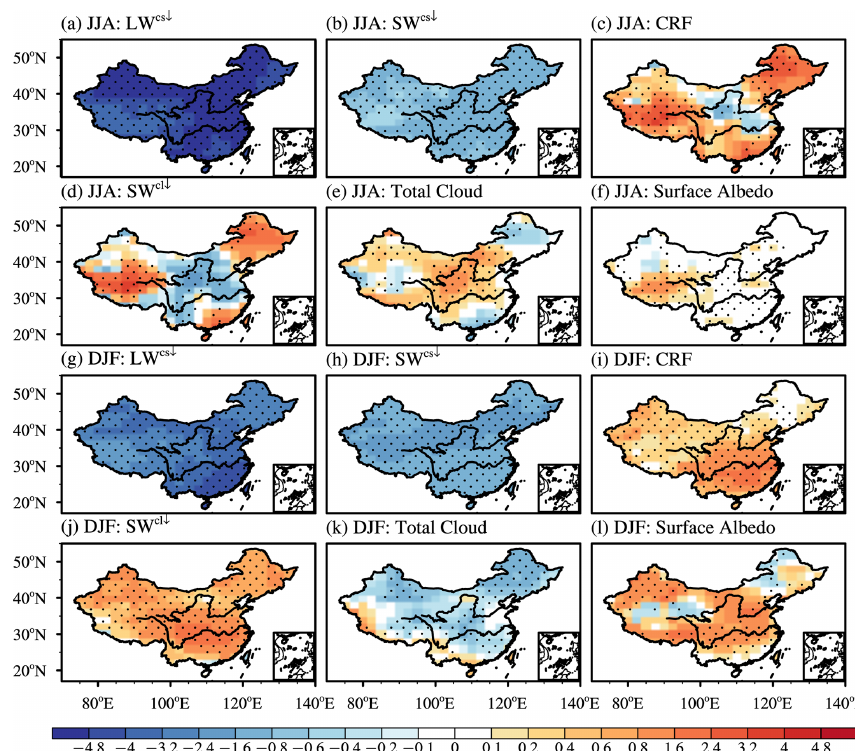
Figure 9. Spatial patterns of differences between G4 and RCP4.5 over China for the multi-model mean in summer (JJA) and winter (DJF) during the period of 2030–2069. (a, g) Downward clear-sky surface longwave radiation (LW cs ↓ ). (b, h) Downward clear-sky surface short- wave radiation (SW cs ↓ ). (c, i) Surface cloud radiative forcing. (d, j) Downward shortwave radiative effect of clouds (SW cl ↓ ). (e, k) Total cloud cover (units in %). (f, l) Surface albedo (units in %). Flux is in watts per square meter (Wm − 2 ). The dots indicate areas where at least two-thirds of the models share the same sign with the multi-model mean.